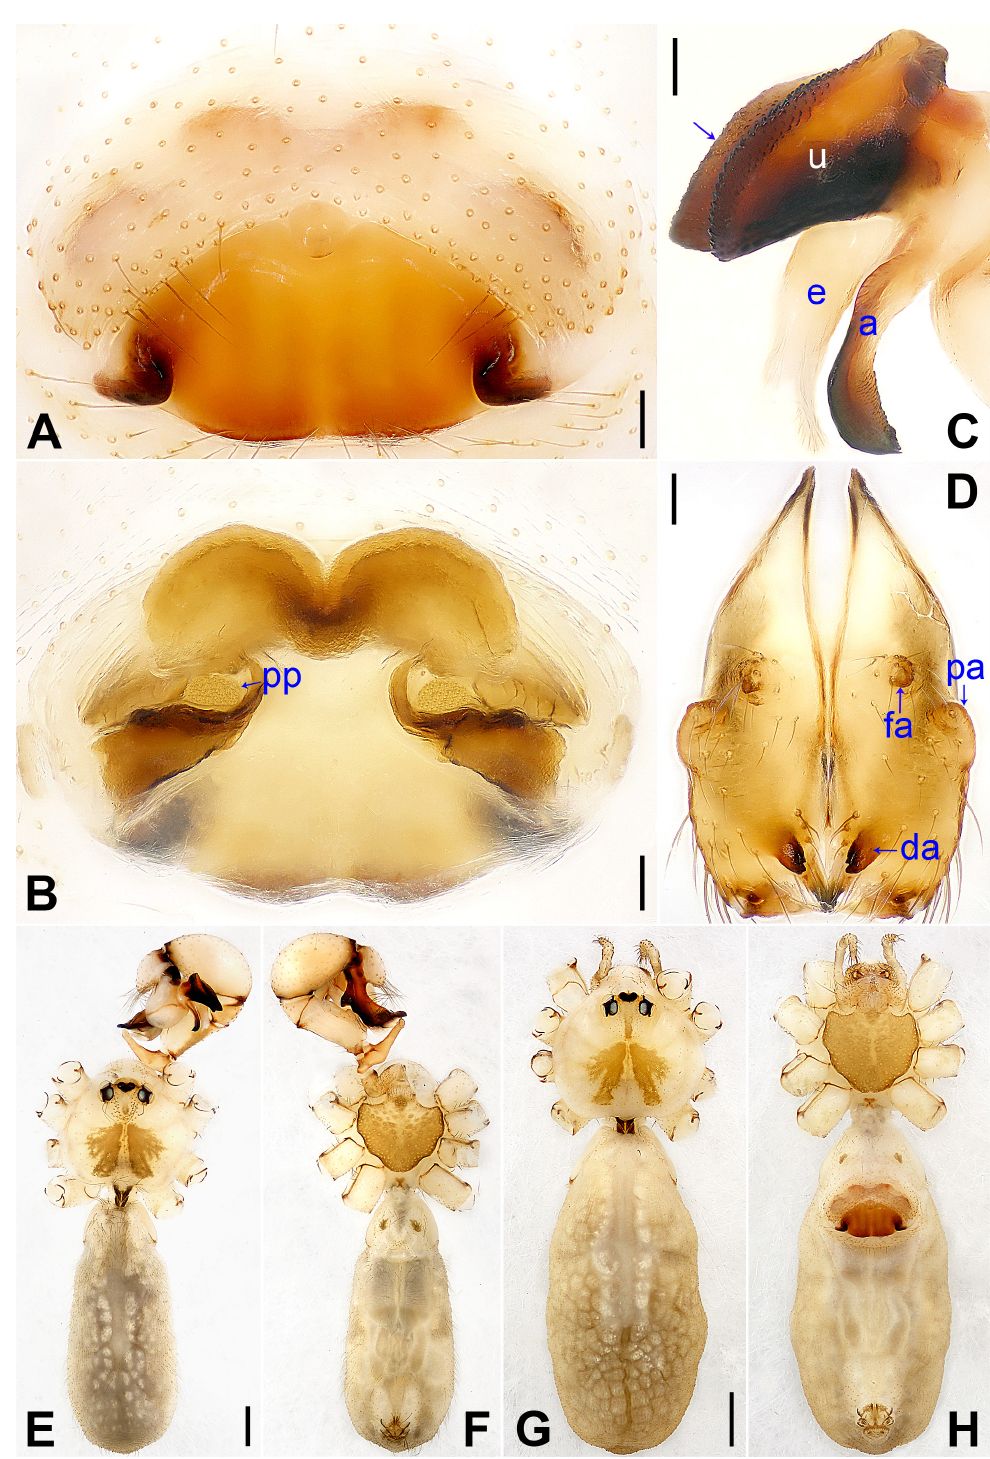
Fig. 2. Pholcus saidovi Yao & Li sp. nov., holotype, ♂ (C–F) and paratype, ♀ (A–B, G–H). A . External genitalia, ventral view. B . Vulva, dorsal view. C . Bulbal apophyses, prolateral view, arrow points at large, sclerotized retrolateral apophysis on uncus. D . Chelicerae, frontal view. E–H . Habitus (E, G. Dorsal view. F, H. Ventral view). Abbreviations: a = appendix; da = distal apophysis; e = embolus; fa = frontal apophysis; pa = proximo-lateral apophysis; pp = pore plate; u = uncus. Scale bars: A–D = 0.10 mm; E–H = 0.50